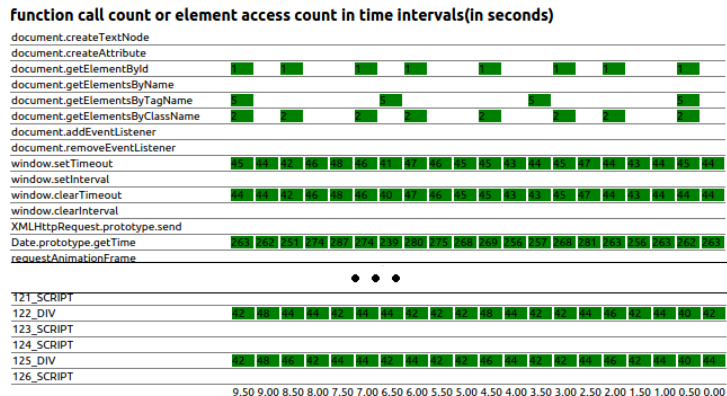
Figure 4. This chart illustrates the real-time states, including the number of function calls and HTML element accesses in time intervals.